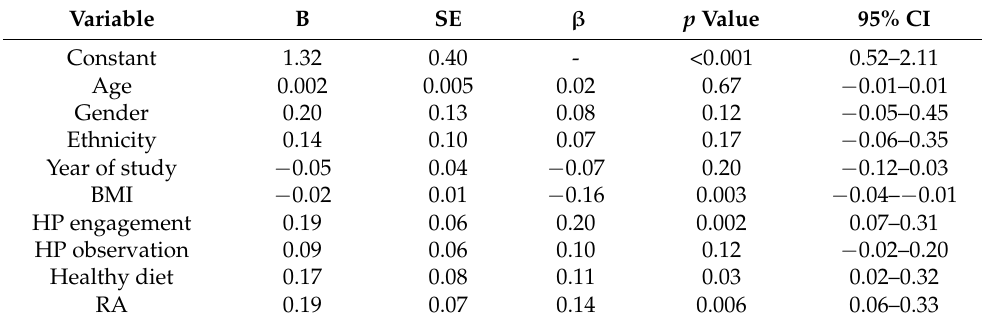
Table 5. Linear regression model predicting confidence in patients valuing HP advice ( n = 343).